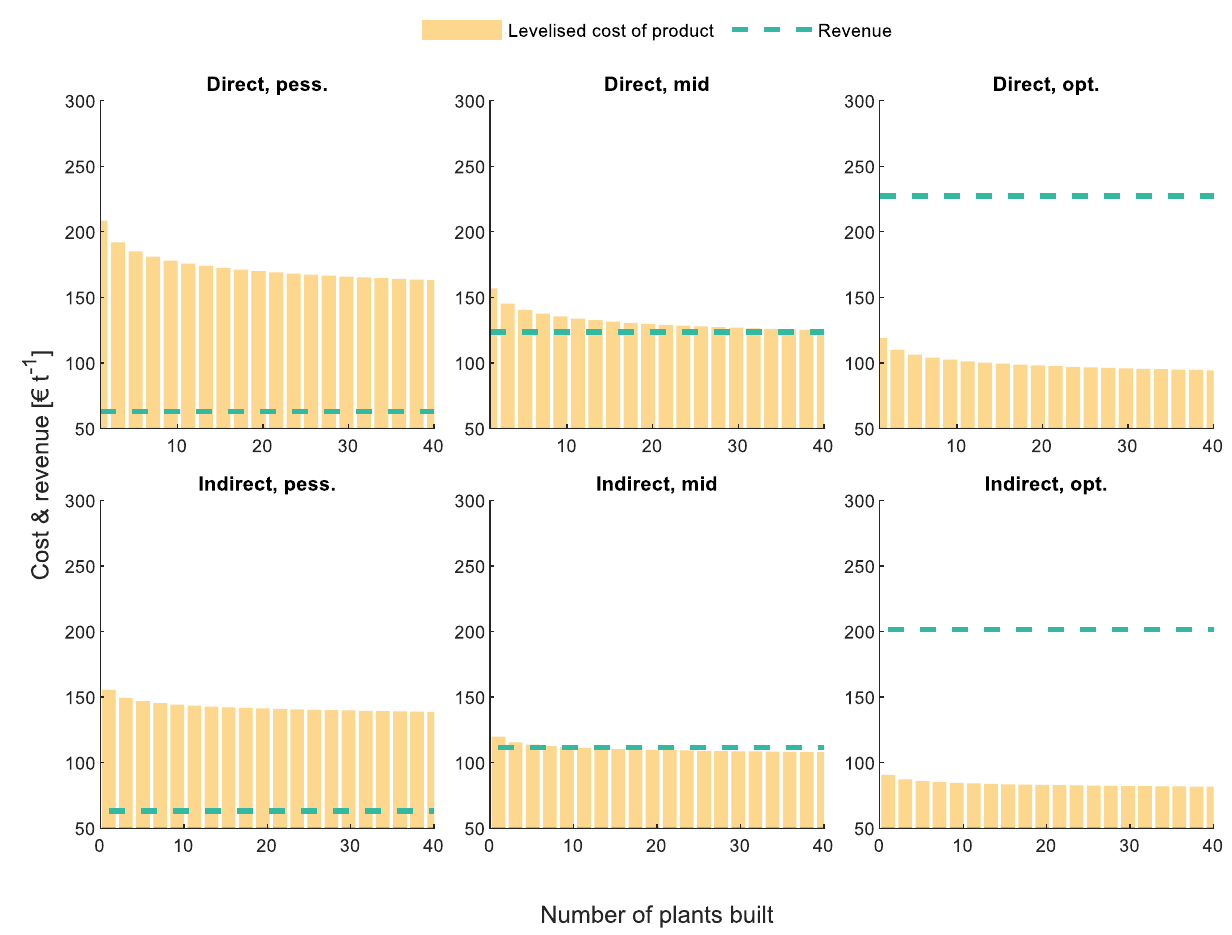
Fig. 5 Impact of number of plants built on the levelised cost of product. Levelised cost of product (beige columns) calculated based on the number of plants built and compared to the resulting revenue (green dashed